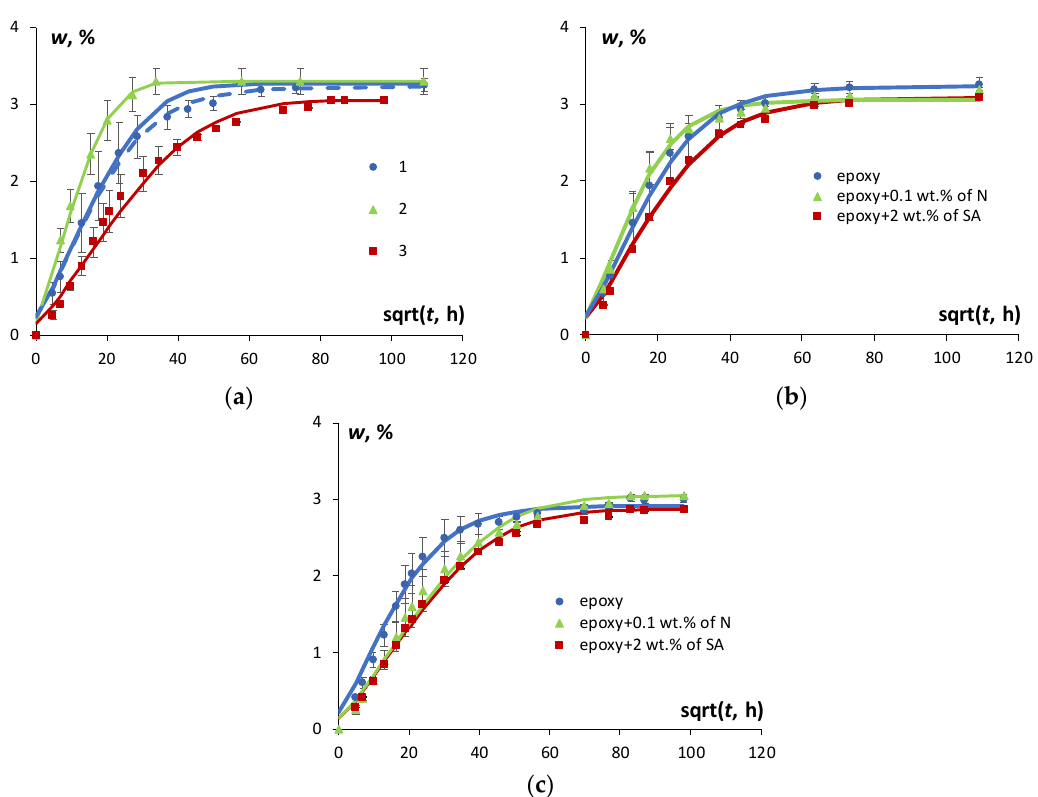
Figure 2. Moisture kinetics of epoxy specimens for moisture absorption (1), desorption (2), and resorption (3) at a relative humidity of 91% during moisture absorption and resorption and 24% during desorption ( a ). Moisture absorption ( b ) and resorption ( c ) for the epoxy and the epoxy filled with 0.1 wt % of N and 2 wt % of SA in an atmosphere with 91% relative humidity (RH). Dots — experimental data, lines — calculation by Equations (1) (a – solid, c) and (5) (a – dashed, b).